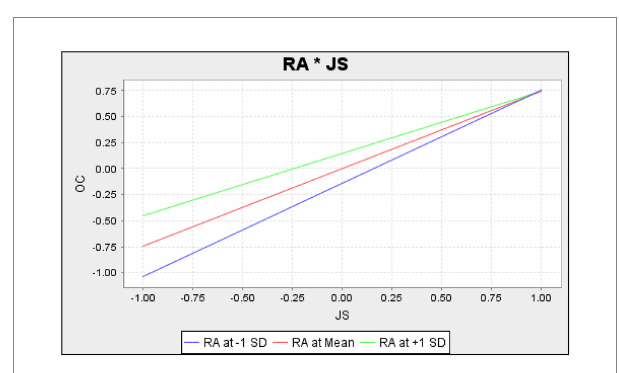
FIGURE 4 Moderation effect of role ambiguity between job satisfaction and organizational